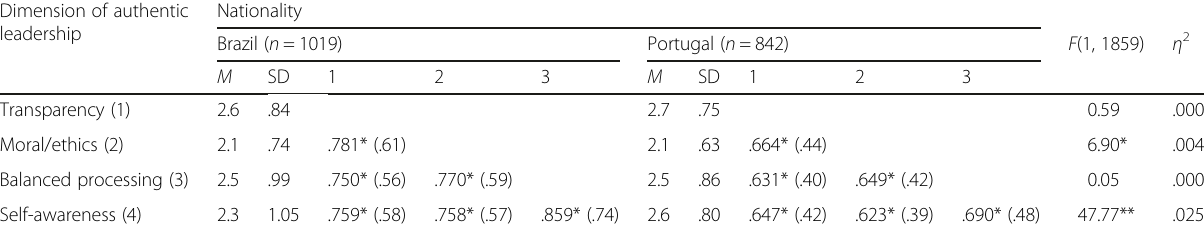
Table 5 Descriptive statistics and inter-correlations between dimensions of AL ( r 2 in parenthesis), univariate tests, and effect size ( η 2 ) for the Brazilian and Portuguese samples Dimension of authentic